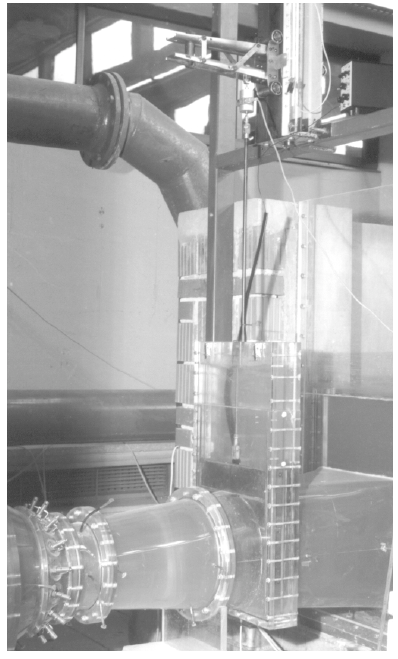
Fig. 1. Kaplan turbine model – bulb